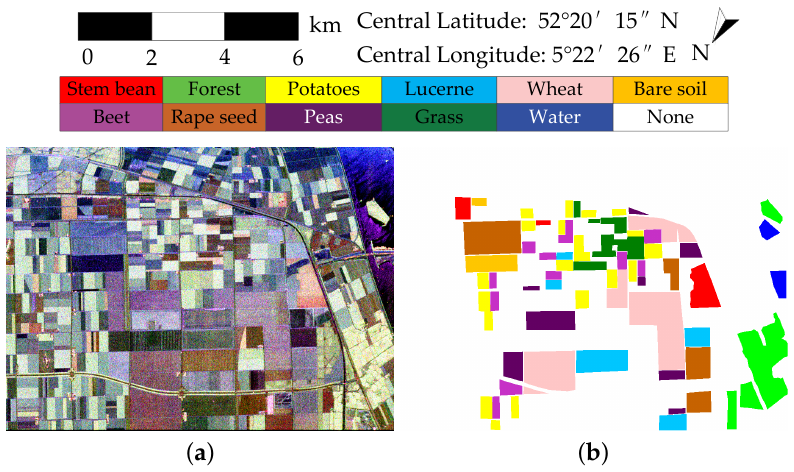
Figure 7. AIRSAR Flevoland dataset and the ground truth map. ( a ) Pauli pseudo-color image of AIRSAR Flevoland; ( b ) Ground truth map of AIRSAR